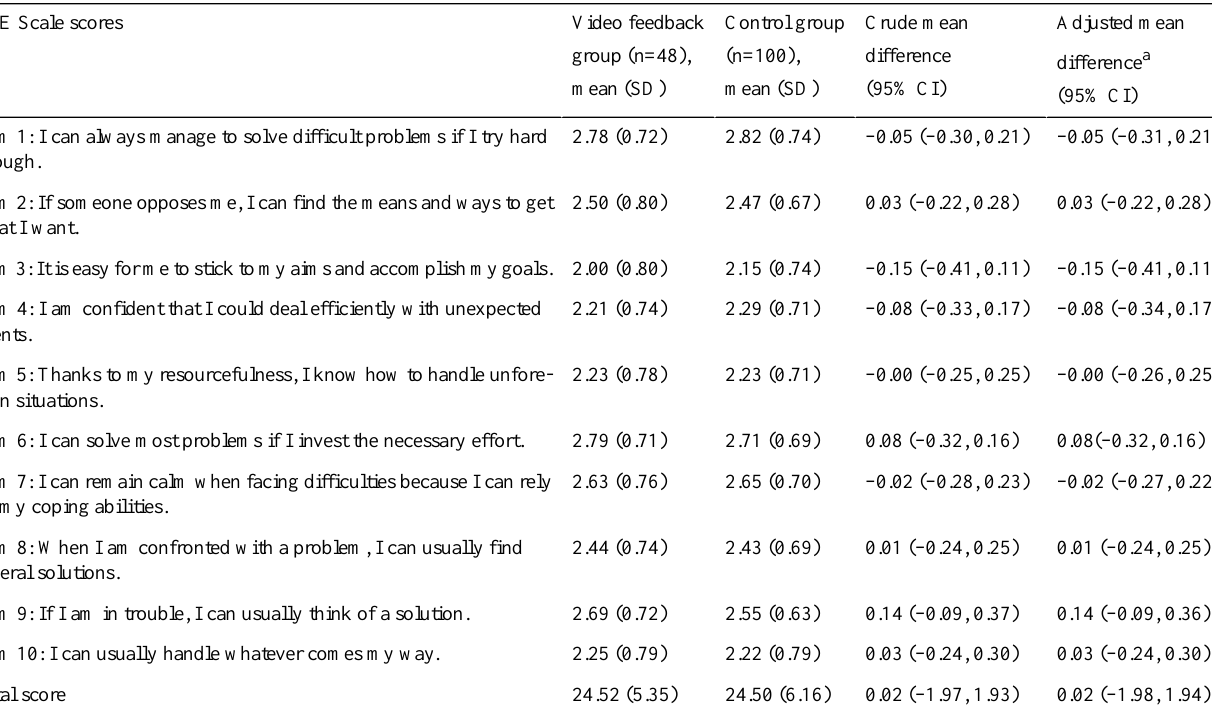
Table 3. Comparison of scores of the General Self-Efficacy (GSE) Scale between the intervention and control groups.